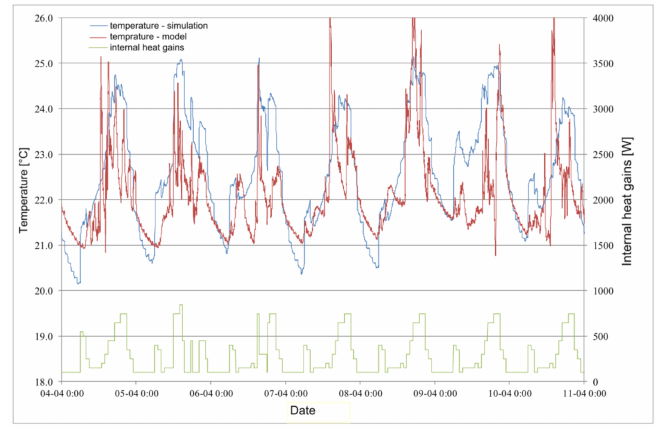
Figure 2. Air temperature and heat gains in zone 2, 4–11